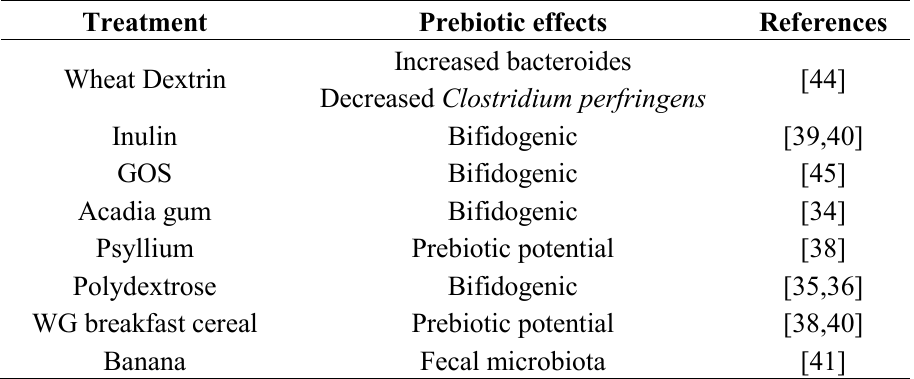
Table 2. Human studies with fibers that show prebiotic